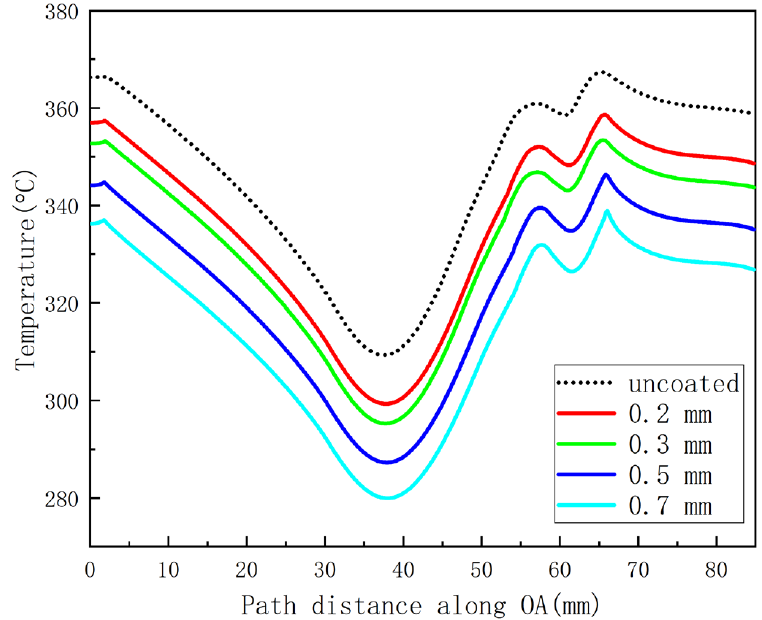
Figure 10. Substrate surface temperature distribution with coating thickness along the path distance OA. Figure 11. The maximum temperature of TC increased with the thickness of the coating, while the maximum temperature of the BC and the substrate decreased with the thickness of the coating. The temperature changes of the substrate and the BC were very close, and the temperature difference between them was less than 7 ◦ C. Smaller temperature difference meant lower thermal stress between TC and substrate, which increased the reliability of the coating.